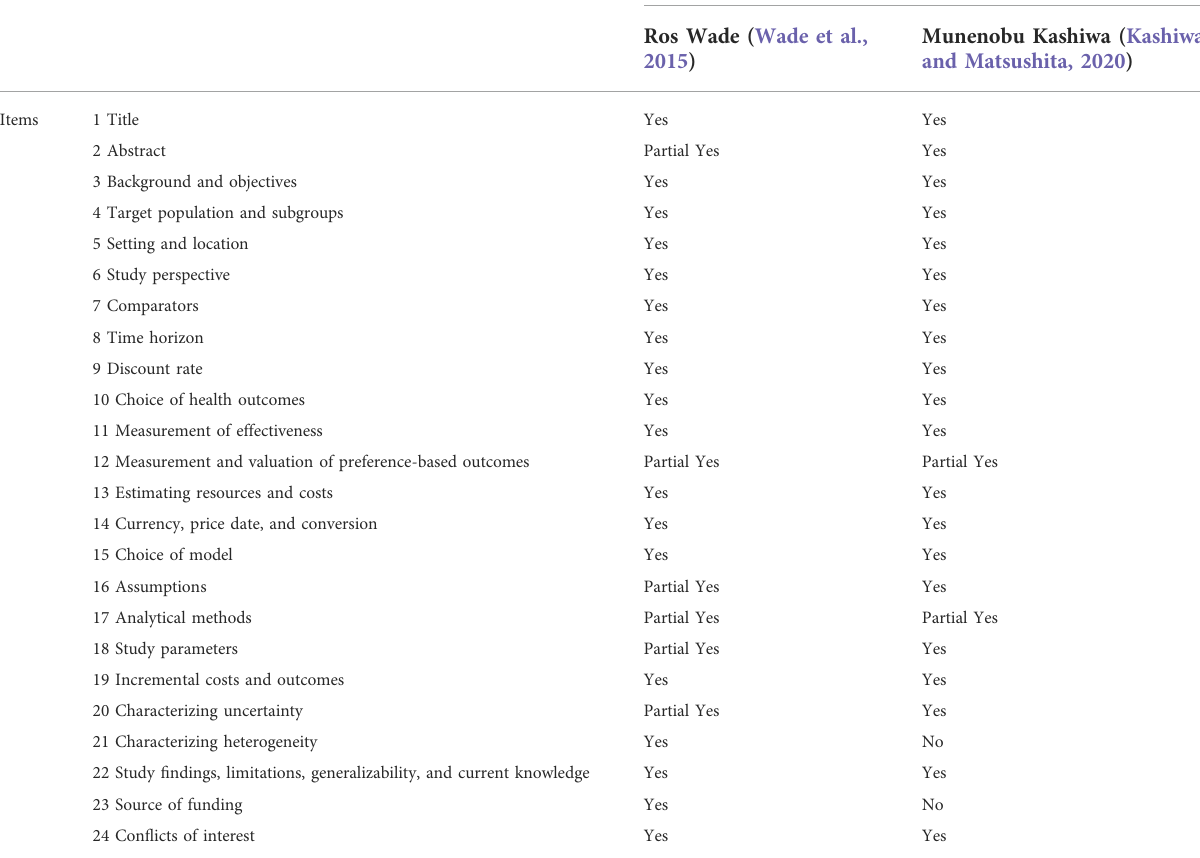
TABLE 7 Quality evaluation of included pharmacoeconomic